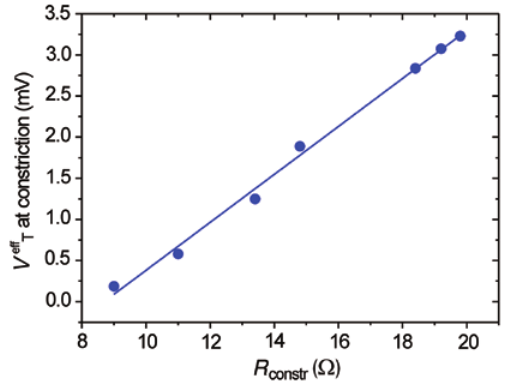
Figure 6: Evolution of the effective threshold voltage